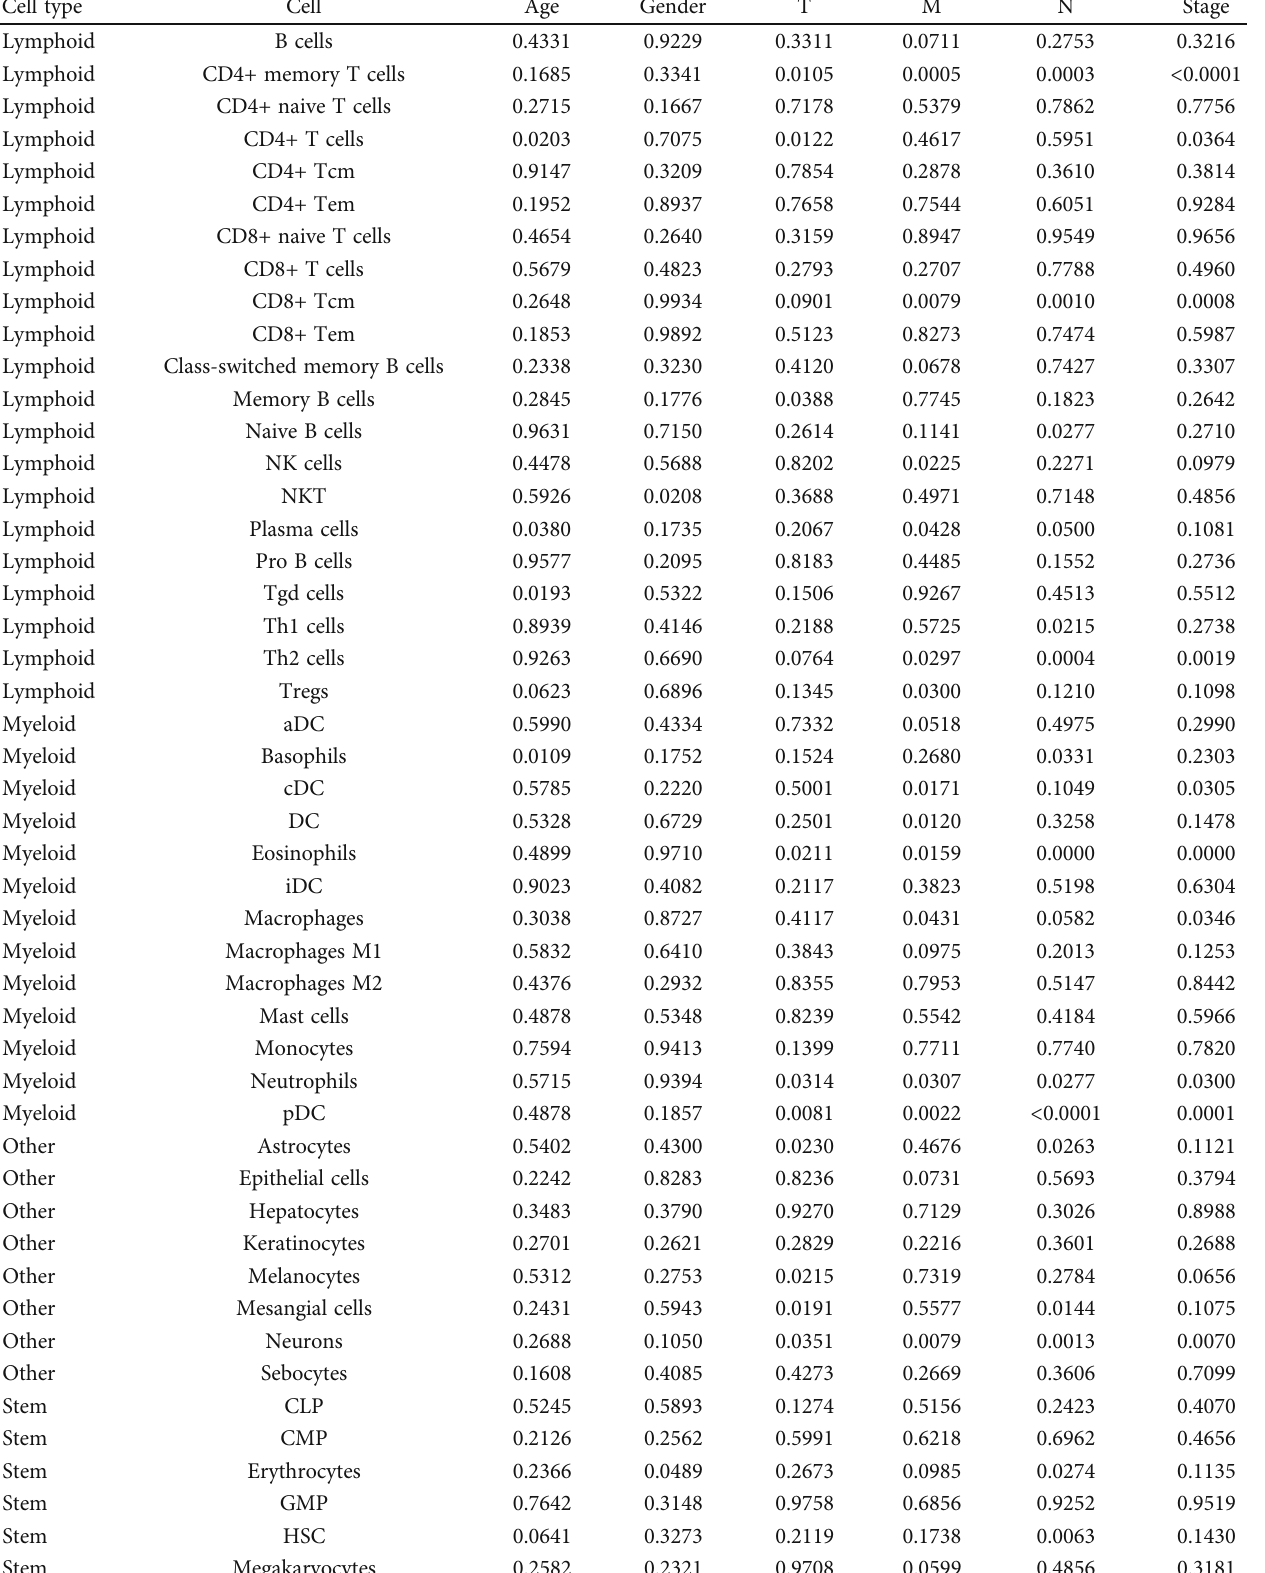
Table 1: Association of in fi ltrating cells with clinical parameters of